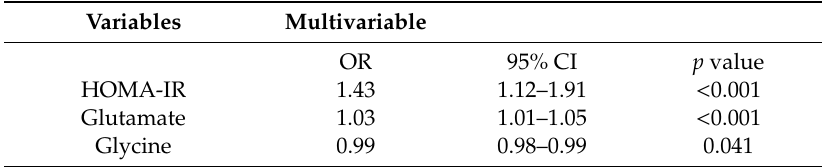
Table 6. Multivariate analysis of risk factors for liver